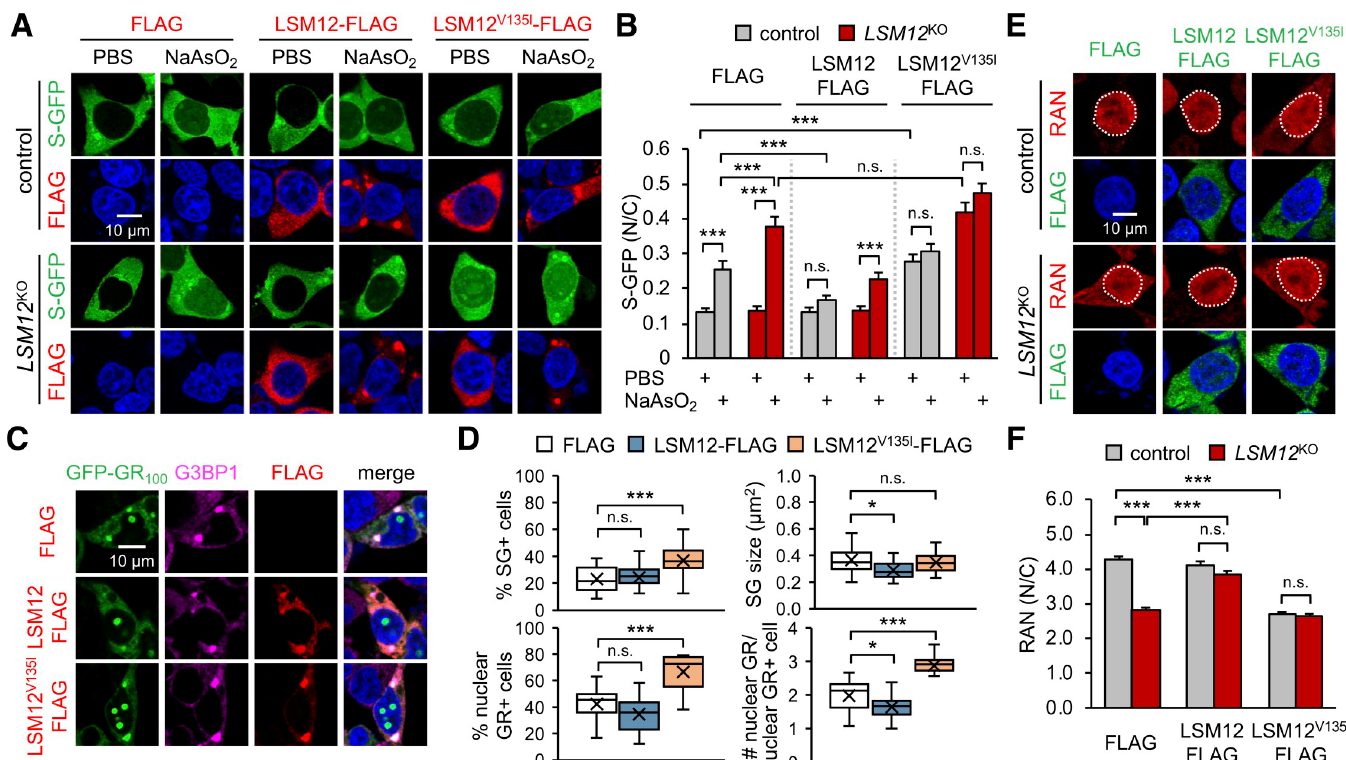
Fig 4. An LSM12 V135I mutant allele exhibits dominant-negative effects on the RAN gradient. (A) Overexpression of LSM12 V135I mutant protein impairs NCT. Control and LSM12 KO cells were co-transfected with expression vectors for S-GFP and FLAG-tagged LSM12 (wild-type or LSM12 V135I mutant). Transfected cells were treated with 50- μ M NaAsO 2 or PBS (vehicle control) for 2 hours and then co-stained with anti-FLAG antibody (red) and Hoechst 33258 (blue) 48 hours after transfection. (B) NCT of S-GFP reporter proteins was quantified as in Fig 2B. Two-way ANOVA detected significant interaction effects of arsenite treatment and LSM12 deletion on NCT only in FLAG-expressing cells ( P = 0.0026). Data represent means ± SEM ( n = 119–138 cells from 3 independent experiments). n.s., not significant; ��� P < 0.001, as determined by Tukey post hoc test. (C) Overexpression of LSM12 V135I mutant protein promotes the nuclear accumulation of poly(GR) granules. SH-SY5Y cells were co-transfected with expression vectors for GFP-GR 100 and FLAG-tagged LSM12 (wild-type or LSM12 V135I mutant) and then co-stained with anti- FLAG antibody (red), anti-G3BP1 antibody (magenta), and Hoechst 33258 (blue) 48 hours after transfection. (D) The assemblies of poly(GR)-induced SGs and nuclear poly(GR) granules were quantified as in Fig 1. Data represent means ± SEM ( n = 19 confocal images obtained from 3 independent experiments; n = 279–327 GFP-GR 100 – positive cells). n.s., not significant; � P < 0.05, ��� P < 0.001, as determined by 1-way ANOVA with Dunnett post hoc test. (E) Overexpression of LSM12 V135I mutant protein disrupts the nucleocytoplasmic RAN gradient. Control and LSM12 KO cells were transfected with an expression vector for FLAG-tagged LSM12 (wild-type or LSM12 V135I mutant) and then co-stained with anti-RAN antibody (red), anti-FLAG antibody (green), and Hoechst 33258 (blue) 48 hours after transfection. (F) The nucleocytoplasmic RAN gradient was quantified as in Fig 2D. Data represent means ± SEM ( n = 119–120 cells from 3 independent experiments). n.s., not significant; ��� P < 0.001, as determined by 2-way ANOVA with Tukey post hoc test. All underlying numerical values are available in S1 Data. ANOVA, analysis of variance; GFP, green fluorescent protein; LSM12, like-Sm protein 12; SEM, standard error of the mean; N/C, nuclear to cytoplasmic; NCT, nucleocytoplasmic